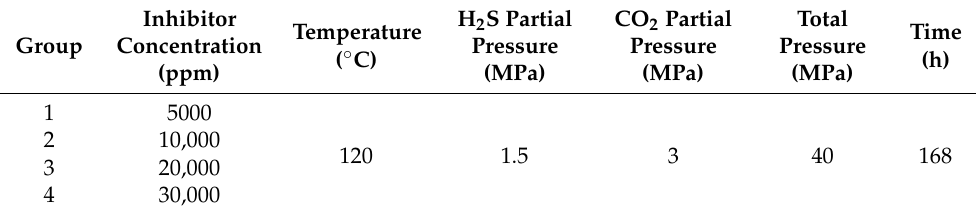
Table 5. Experimental scheme for corrosion inhibitor concentration selection.